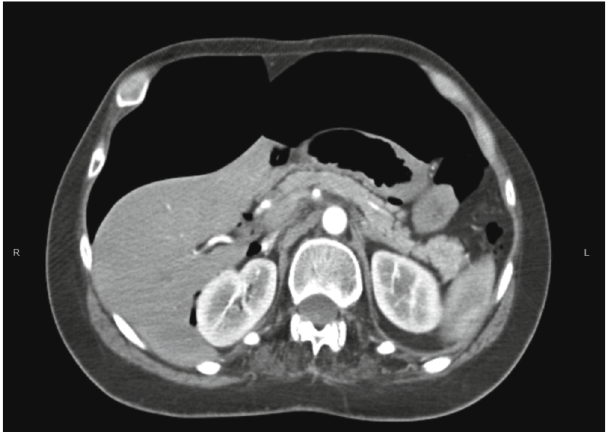
Figure 2: Computed tomography (CT) scan of the chest, abdomen, and pelvis (axial